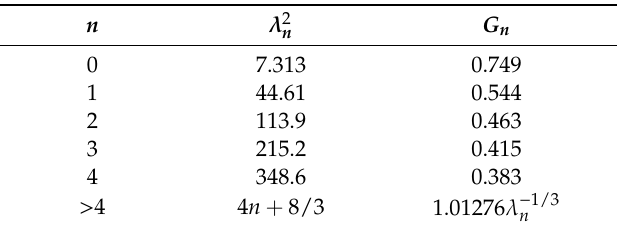
Table 1. Infinite-series-solution functions for the circular tube, constant surface temperature, and thermal-entry length [14].